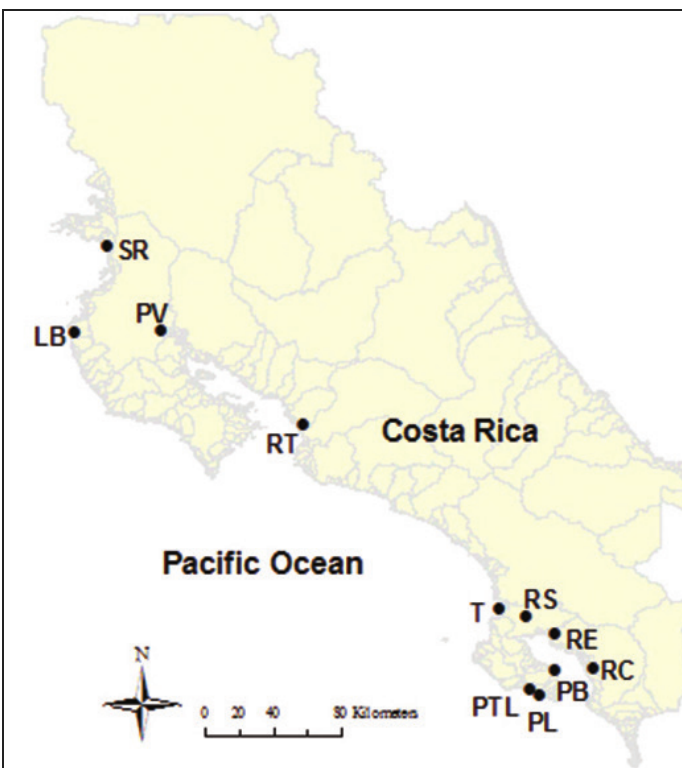
Figure 1. Map of collection sites in Costa Rica of the American crocodile, Crocodylus acutus . Parque Nacional Marino Las Baulas (LB), Parque Nacional Palo Verde (PV), Parque Nacional Santa Rosa (SR), Rio Tarcoles (RT), Rio Sierpe (RS), Terraba Delta (T), Pejeperitto Lagoon (PTL), Pejeperro Lagoon (PL), Rio Esquinas (RE), Rio Coto (RC) and Parrot Bay Lodge (PB). Sites RS, T, PTL, PL, RE, RC, and PB were grouped together as Osa Conservation Area (ACOSA). Localities ranged from large river systems (PV, RT, and ACOSA) to estuaries (LB, SR) and coastal lagoons (SR and ACOSA). Table 1. Size class distribution of genotyped crocodiles for each site.